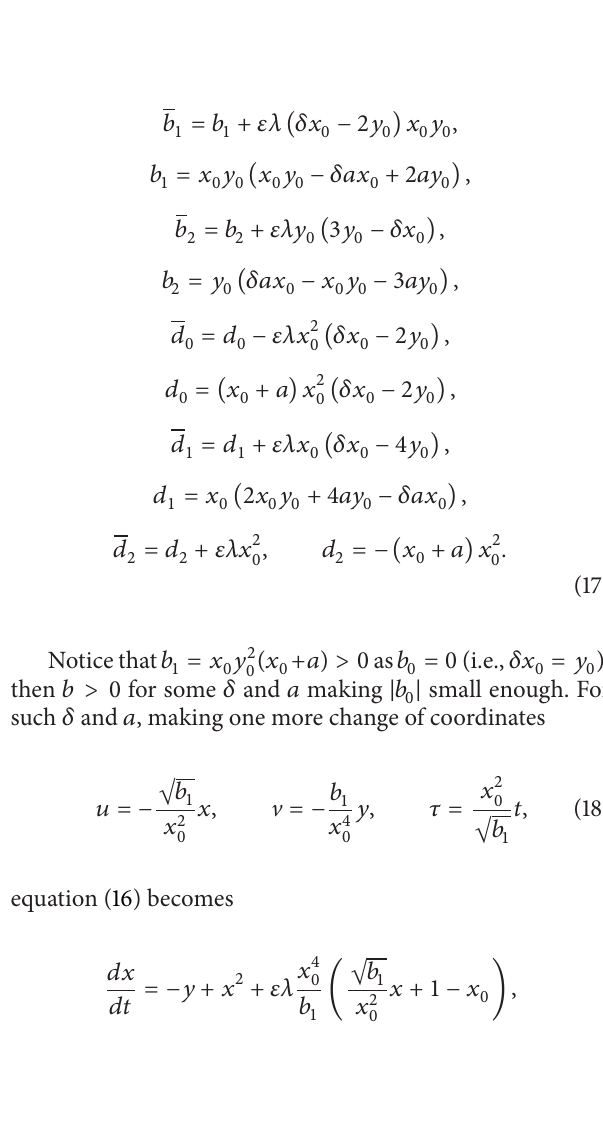
Figure 1: The limit periodic cycle Γ(𝑠) and the slow manifold 𝑆